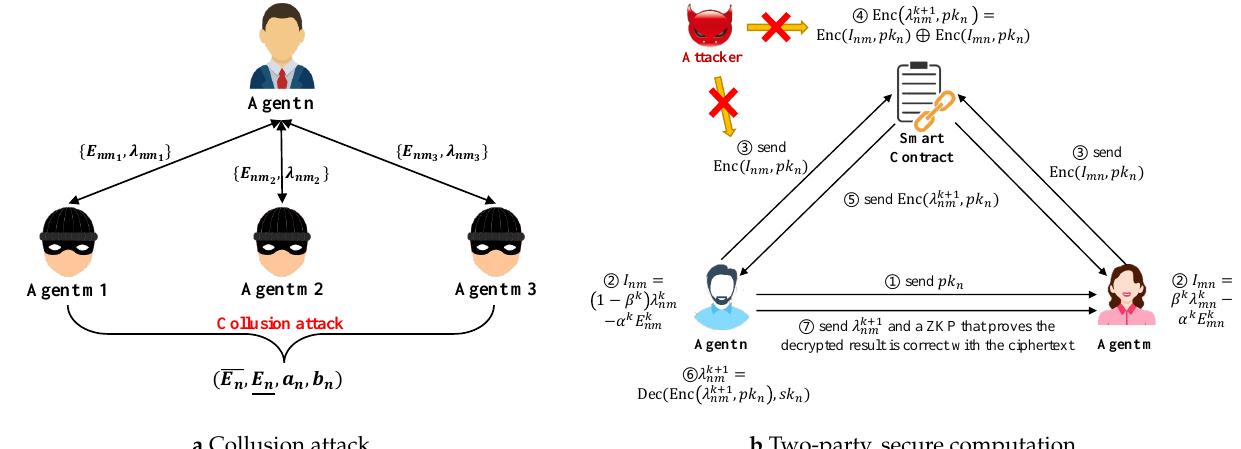
Figure 3. Collusion attack for malicious neighboring agents and two-party, secure computation between two